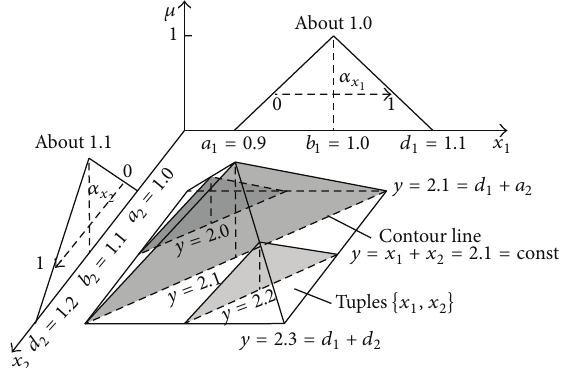
Figure 9: Projection of the full 4D addition result granule onto the 3D space 𝑋 1 × 𝑋 2 × 𝜇 with slant contour lines corresponding to particular addition results 𝑦 = 𝑥 1 + 𝑥 2 =